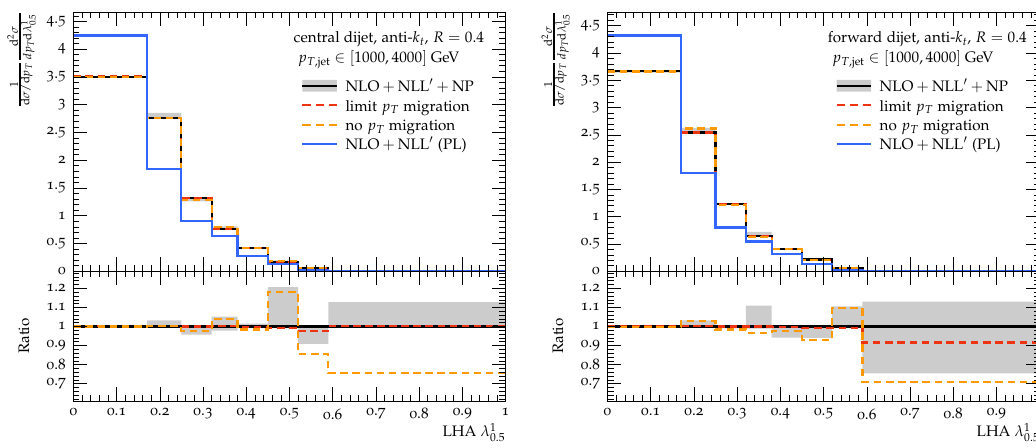
Figure 3. Same as figure 2 but for jets with p T, jet ∈ [1000 , 4000] GeV in the central (left) and forward (right) dijet